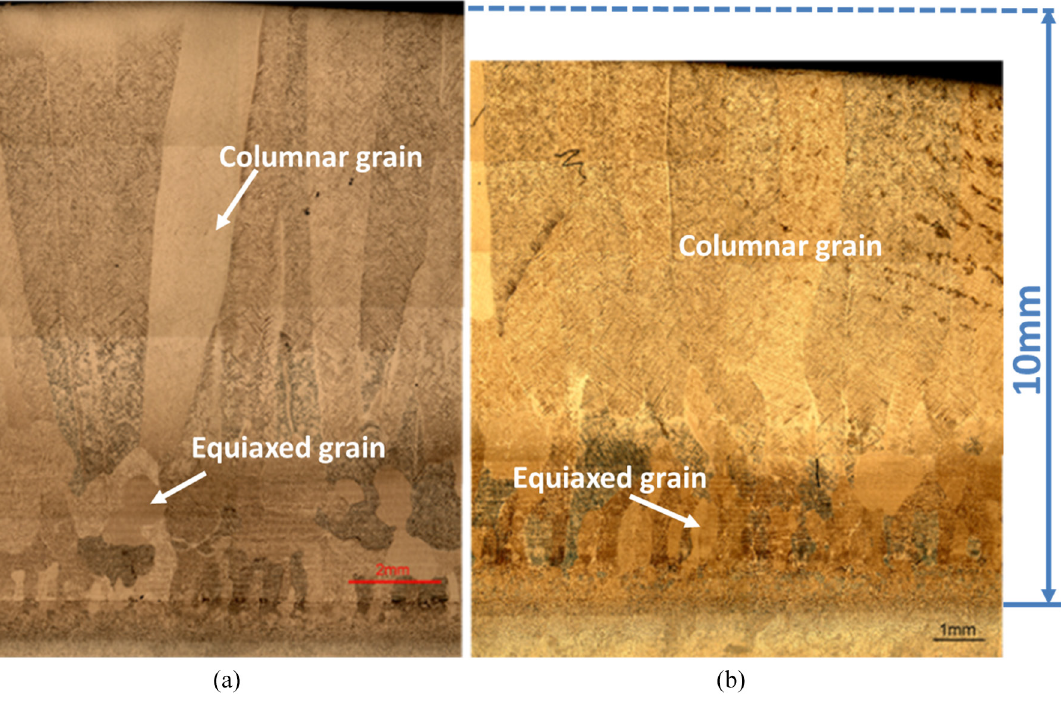
Figure 4. Montage of macrostructure of pulse laser deposition Ti6Al4V thin wall showing large columnar growth prior β grains with duration time of 0.6s (a); 0.9s (b). (Frequency is 500 HZ, scanning speed is 800 mm/min, and average laser power is 600 W (a); 900 W